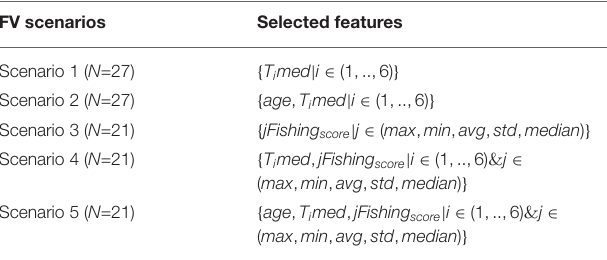
TABLE 3 | The selected features per each feature vector (FV) scenario used as input to the K-Nearest Neighbors (KNN), Support Vector Machine (SVM), and Random Forest (RF)